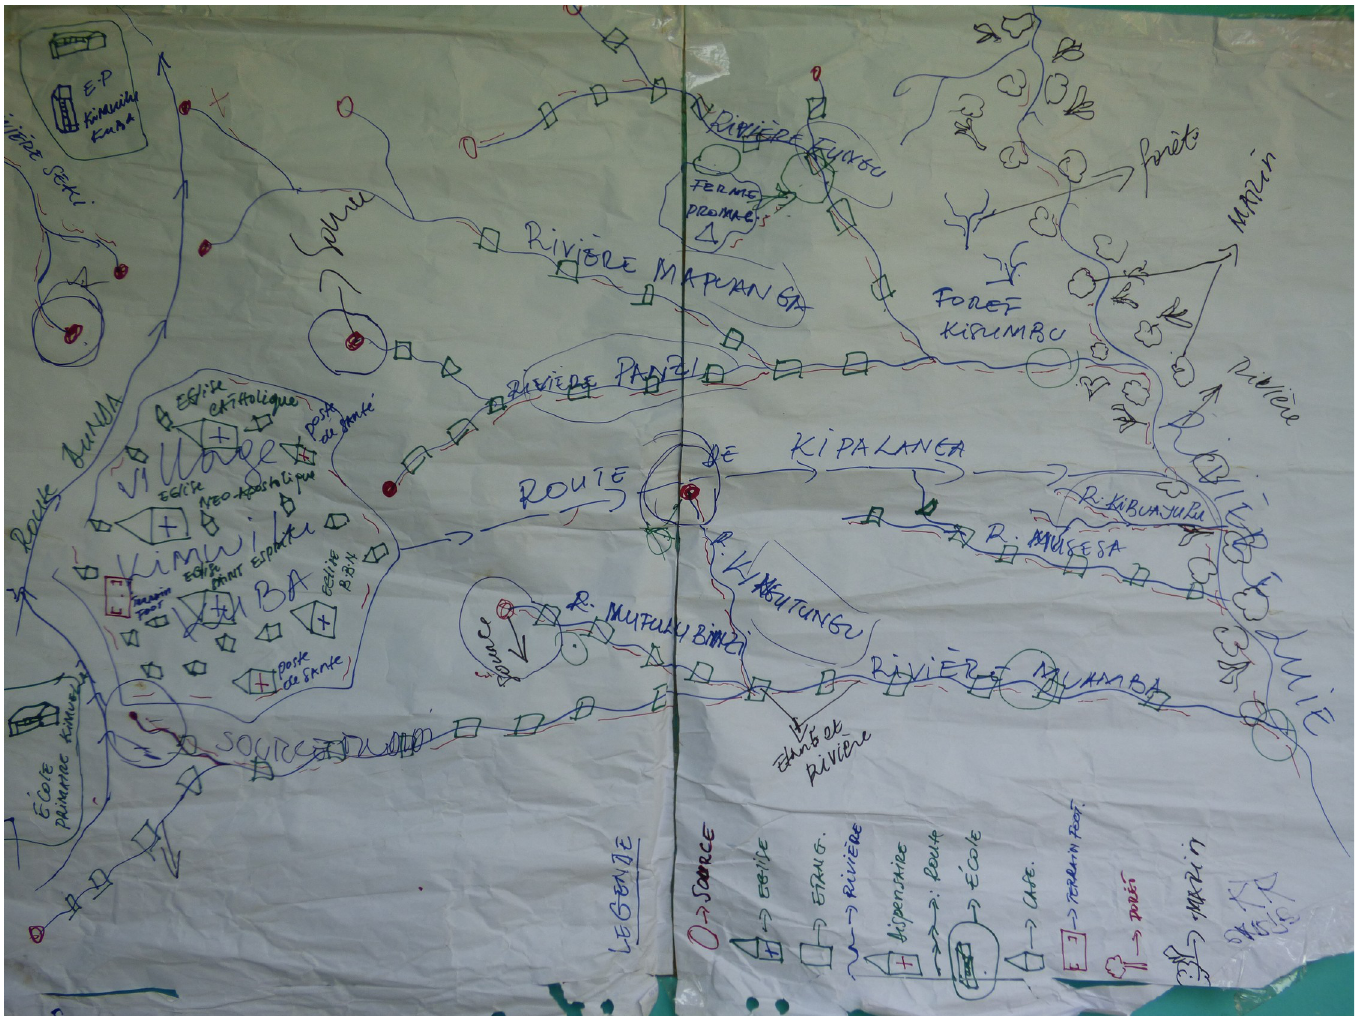
Fig 5. Village map drawn by Kimwilu Kuba Vector Control Committee members: Distribution of the ponds network and perceived contact points. (Credit: CVK).